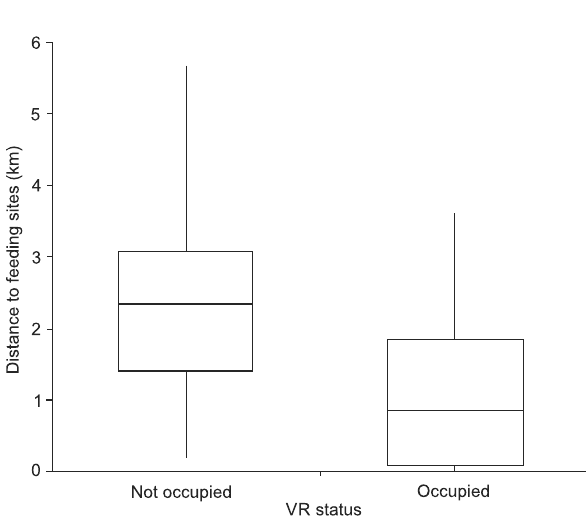
Figure 2. Box plot with median and quartiles feeding site distances from vegetations remnants that are occupied and unoccupied by Black Vultures as communal roosts, Manaus, Amazonas, Brazil.